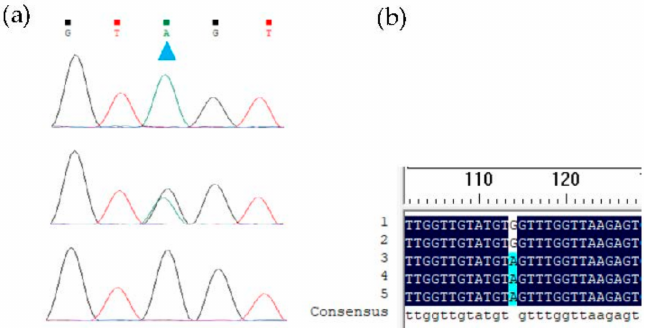
Figure A3. Sequencing validation of the g.112558859 A > G locus of the LCORL gene. ( a ) Sanger sequencing results of the g.112558859 A > G locus. Normal genotype, heterozygote genotype and mutant genotype sequencing maps are shown from top to bottom. ( b ) Sequence alignment results of the g.112558859 A > G